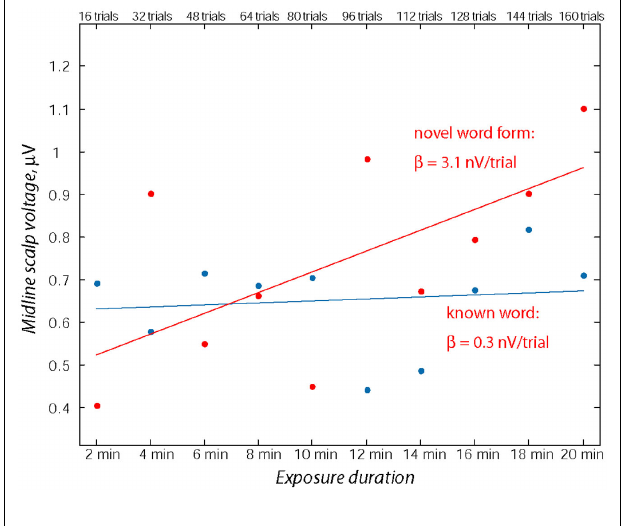
FIGURE 4 |Assessment of ERP magnitude change through the exposure session using linear regression over consecutive 10% sub-blocks. Note the relative stability of the word response in contrast with the marked increase in the pseudo-word response amplitude. Data from both time windows (70–90 and 110–130ms) from midline electrodes (Fz, FCz) were used for computing linear regression for each participant’s responses to known words and novel